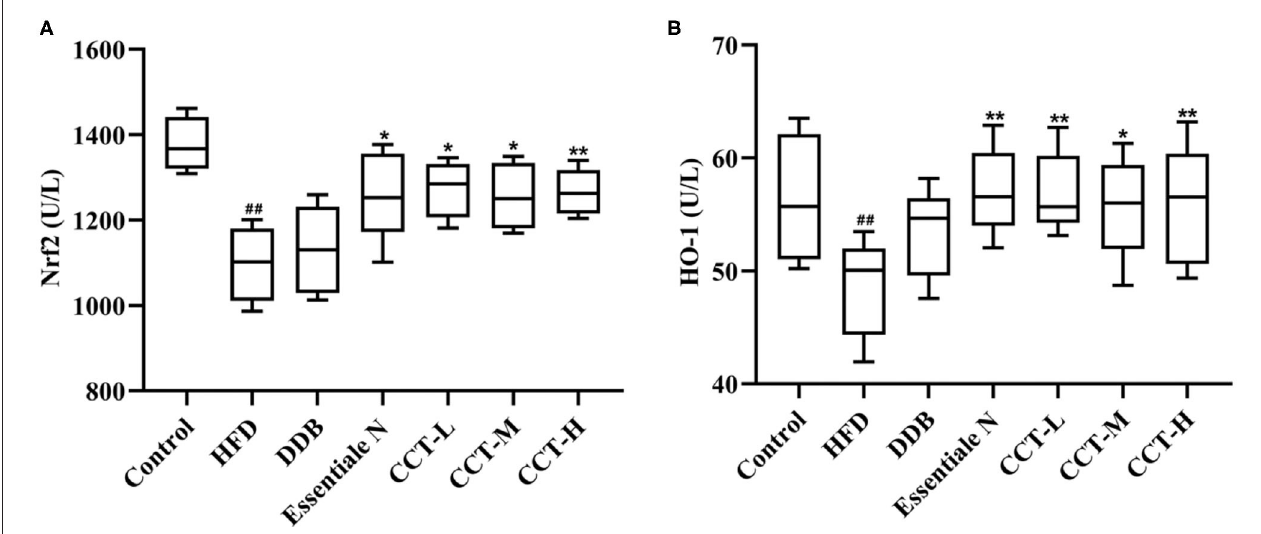
FIGURE 11 | Effects of CCT on Nrf2 and HO-1. (A) Effects of CCT on Nrf2. (B) Effects of CCT on HO-1. ## P < 0.01 vs. Control group; * P < 0.05, ** P < 0.01 vs. HFD